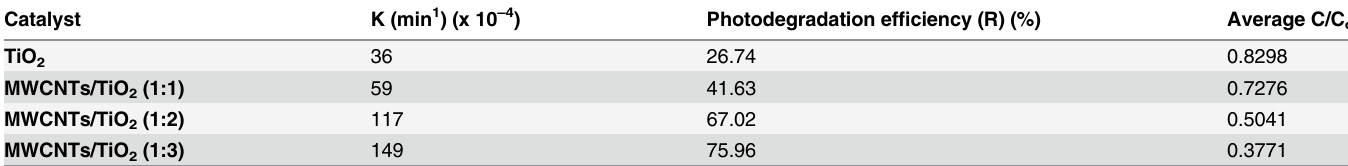
Table 1. The apparent rate constant ( k ), photodegradation efficiency (R) and average C/C o at 10ppm MB initial concentration.